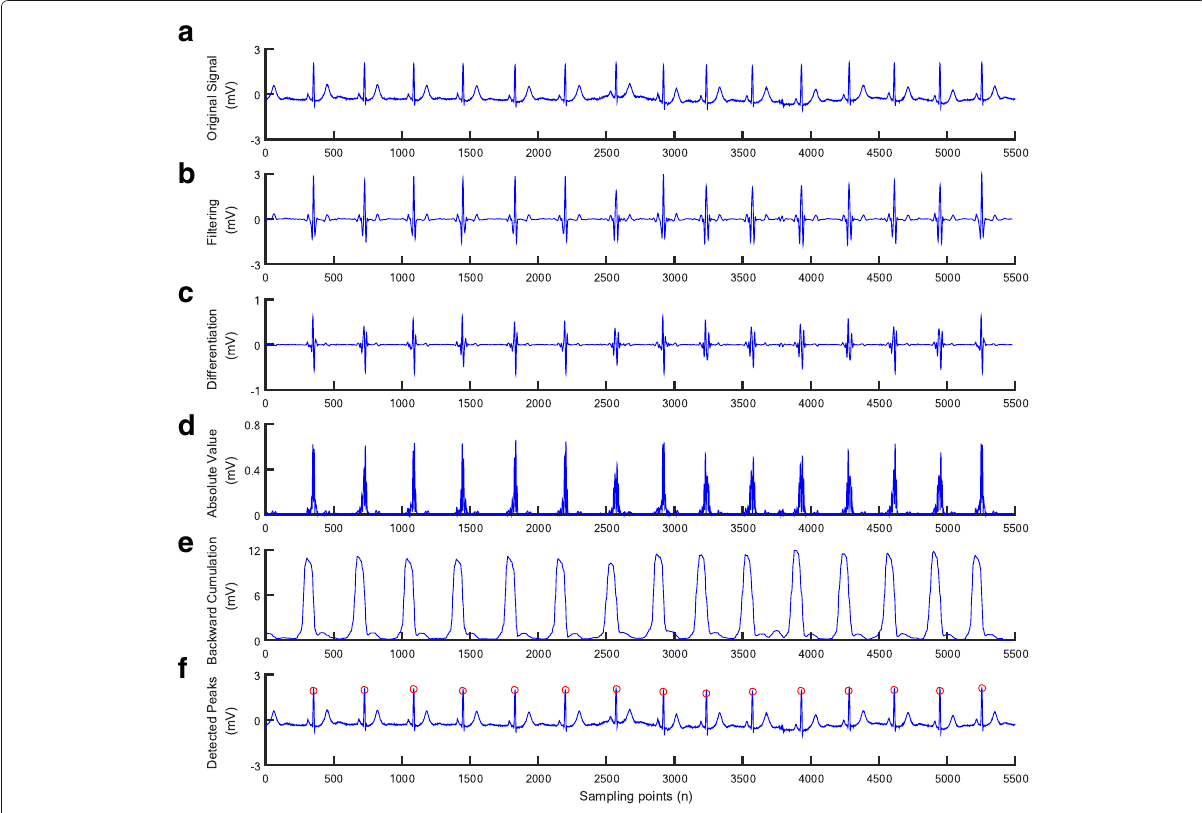
Fig. 8 Results after performing each stage of the method for the ECG with tall T waves (ECG recording 106). a ) Original signal. b ) Filtering. c ) Differentiation. d ) Absolute value. e ) Backward cumulation. f ) Detected